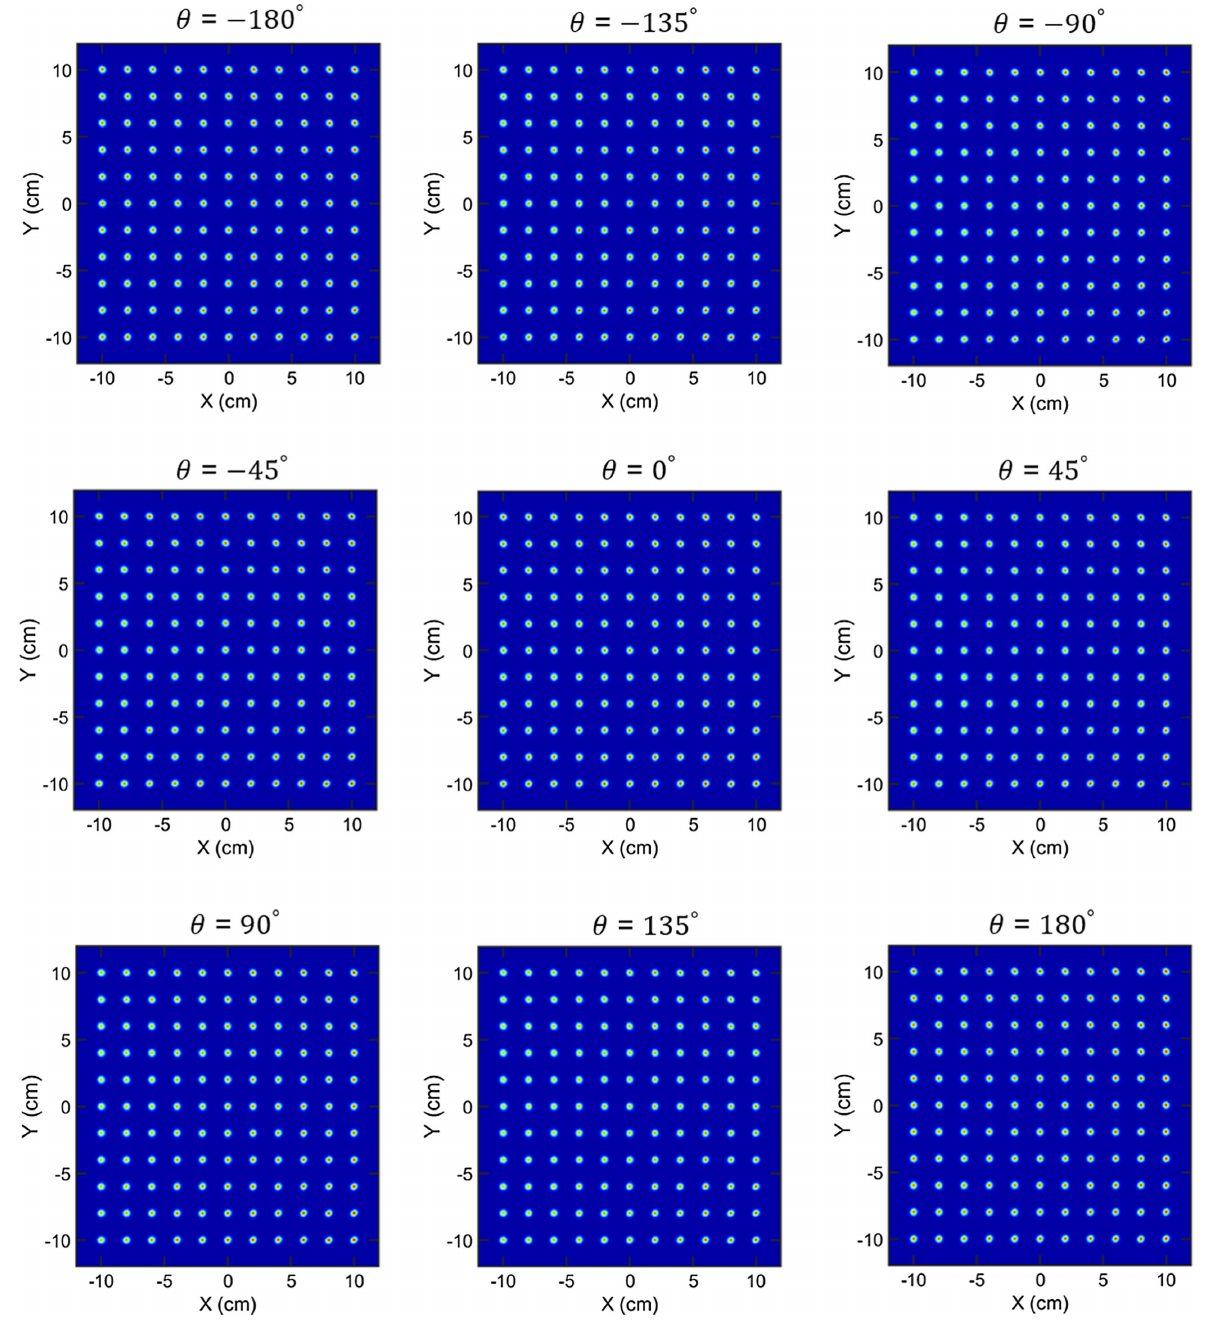
FIG. 15. Beam profiles at the isocenter for rotation angles from − 180 ° to þ 180